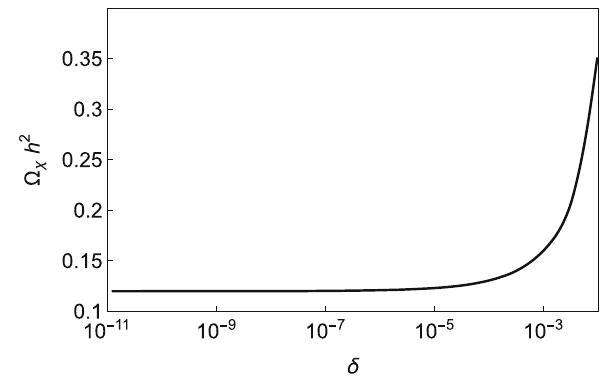
Fig. 1 Relic abundance as a function of δ for g BL = 3 . 46 × 10 − 5 , m Z (cid:2) = 10 GeV and Q χ = 1